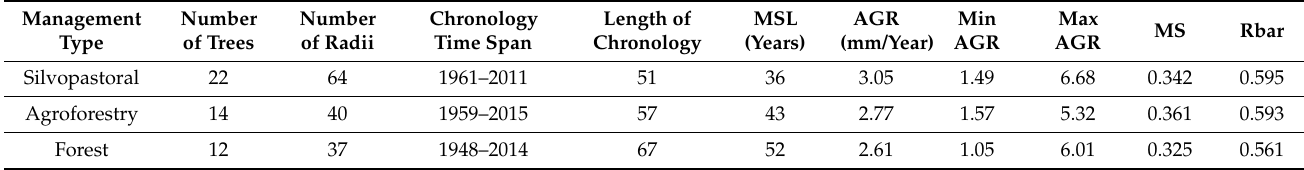
Table 2. Chronology characteristics including number of sample trees and measurement radii, period length, mean segment length (MSL), average growth rate (AGR), minimum and maximum average growth rates, mean sensitivity (MS), and mean inter-series correlation coefficient